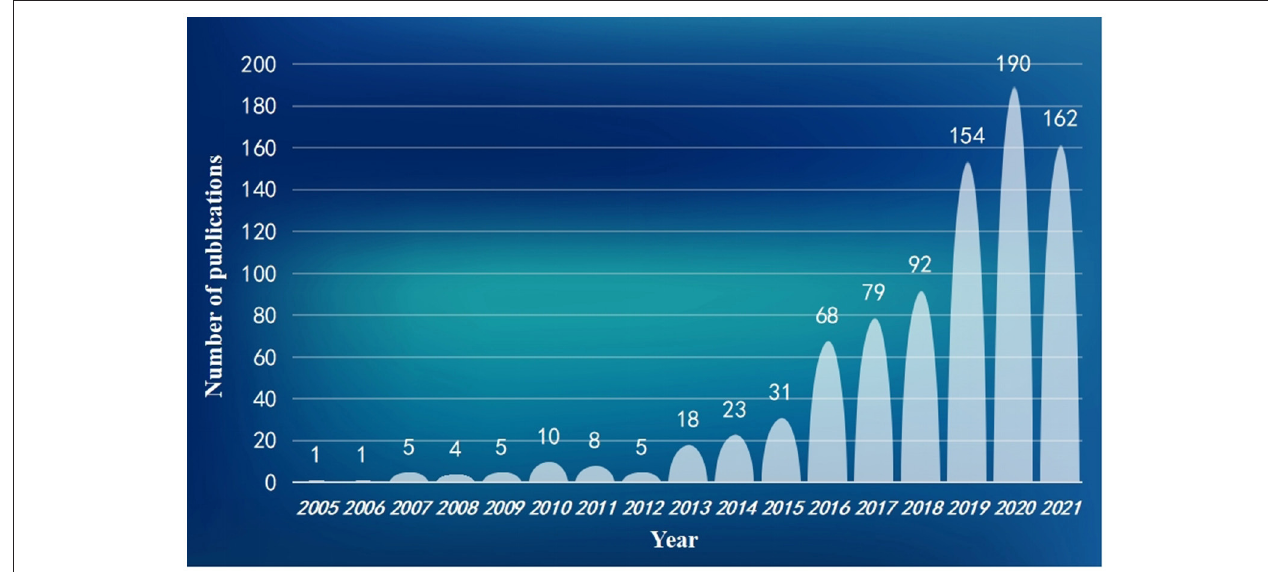
FIGURE 2 | Publication trends on exosomes in the field of neuroscience from 2005 to 2021.